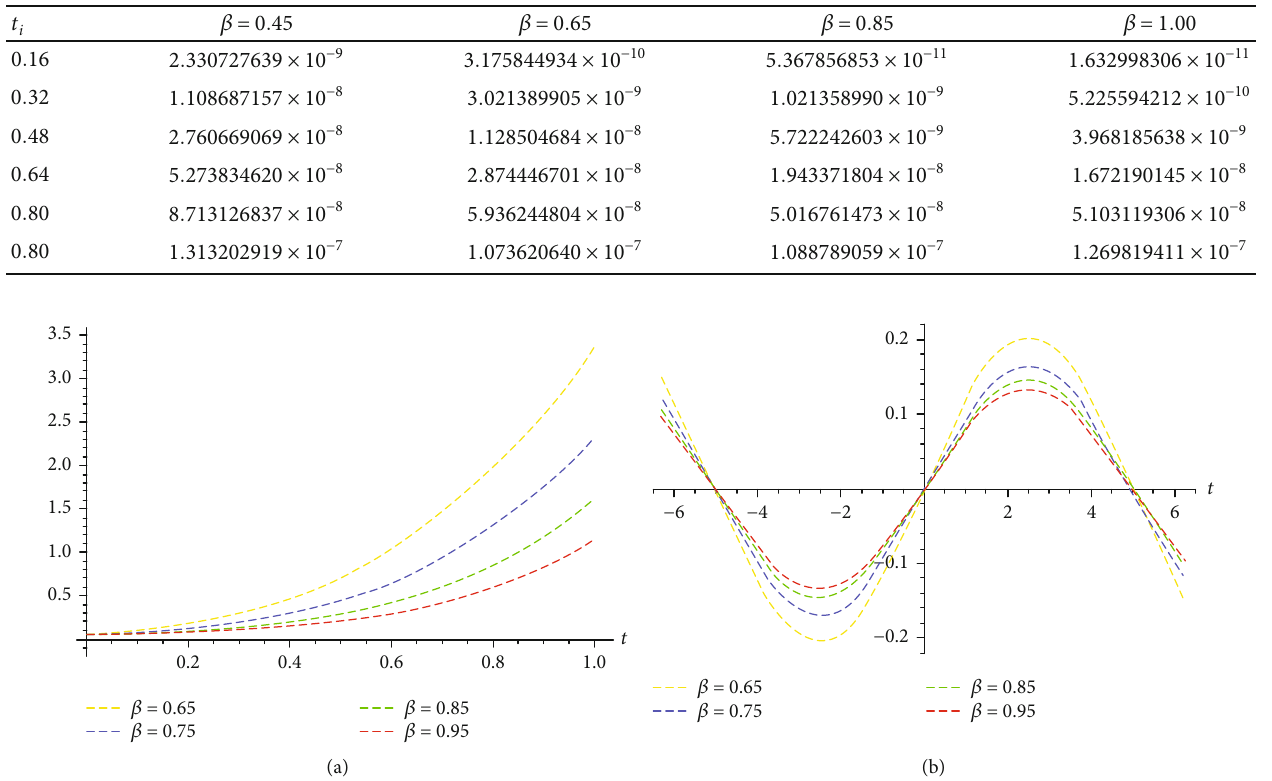
Table 5: The recurrence errors j w